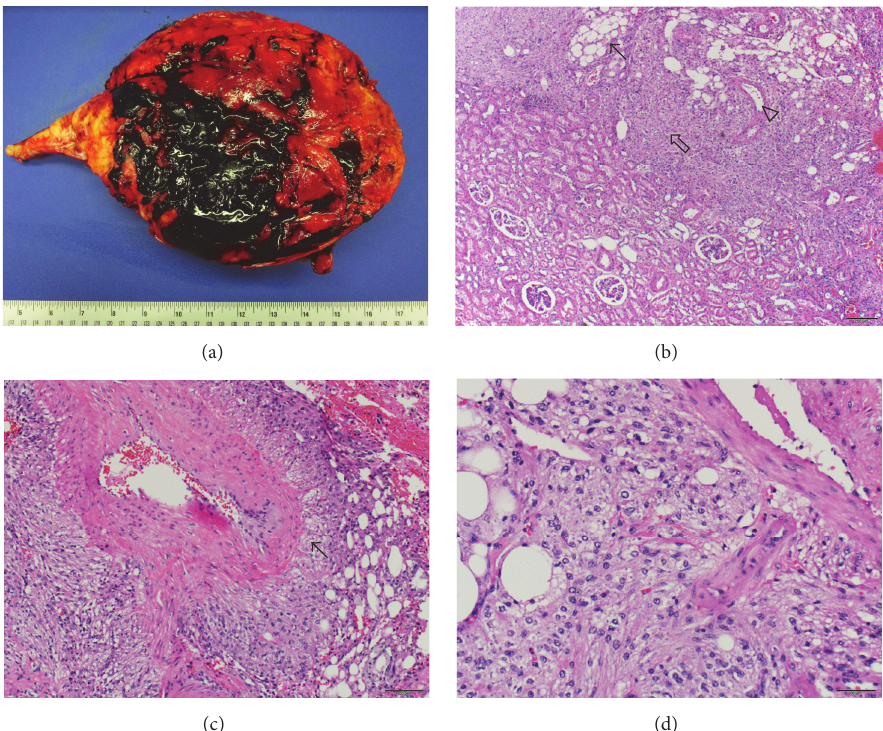
Figure 2: Macroscopic image showing a large circumscribed tumor with extensive hemorrhage (a). Photomicrographs show, arising from the kidney (lower left), an unencapsulated triphasic tumor (upper right) composed of mature adipose tissue (arrow), dystrophic vasculature (arrow head), and smooth muscle (clear arrow) (b). The smooth muscle cells appear to emanate from the wall of an irregular, thick-walled blood vessel (arrow) (c) and are characterized by oval to spindle cells with pale eosinophilic cytoplasm and regular nuclei with small nucleoli (perivascular epithelioid cells) (d).